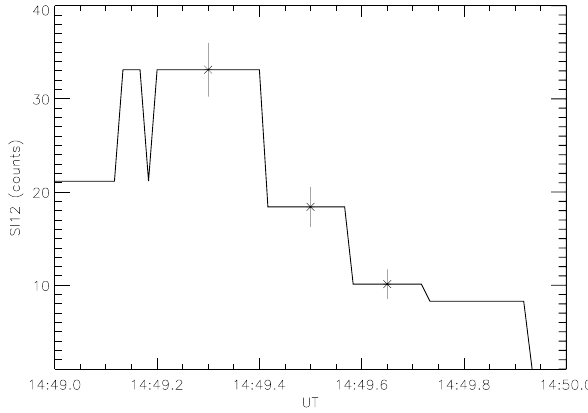
Fig. 6. FUV SI12 observation of a proton auroral arc on 26 Novem- ber 2000. A background value of 4 counts was subtracted from the measurements. The vertical error bars correspond to a one-sigma standard deviation of the count rate.